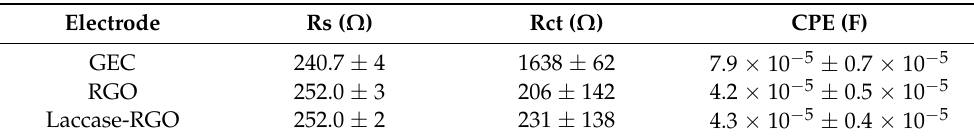
Table 2. Fitted values of circuit elements in the equivalent electric circuit for the different studied surfaces.